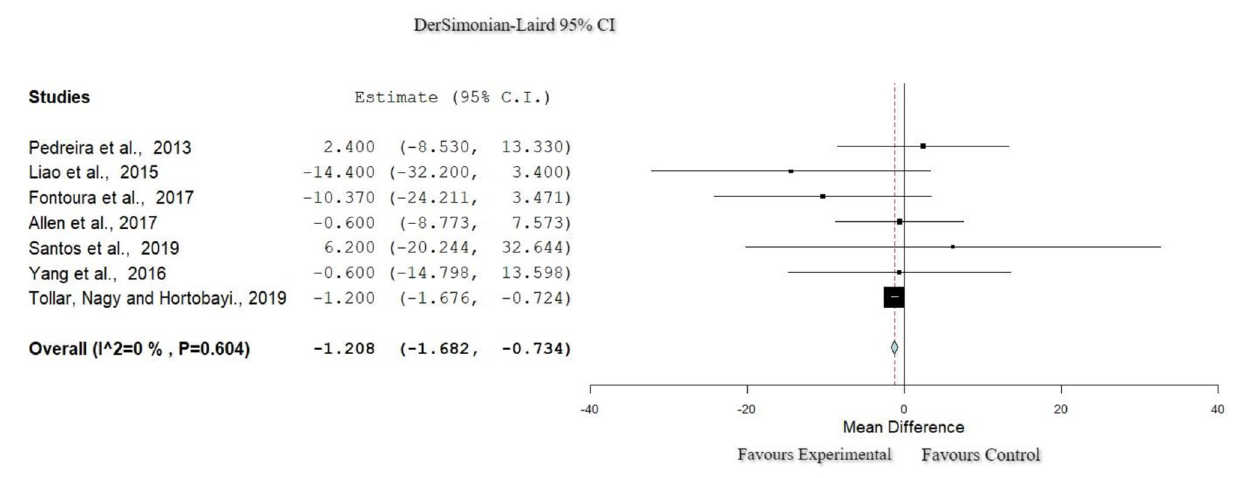
FIGURE 2 | Forest plot for QoL: PDQ-39. The red dash line represents the weighted mean difference of the included studies. The blue figure represents the weighted 95% CI of the included studies. PDQ-39, Parkinson’s Disease Rating Scale-39; QoL, quality of life.